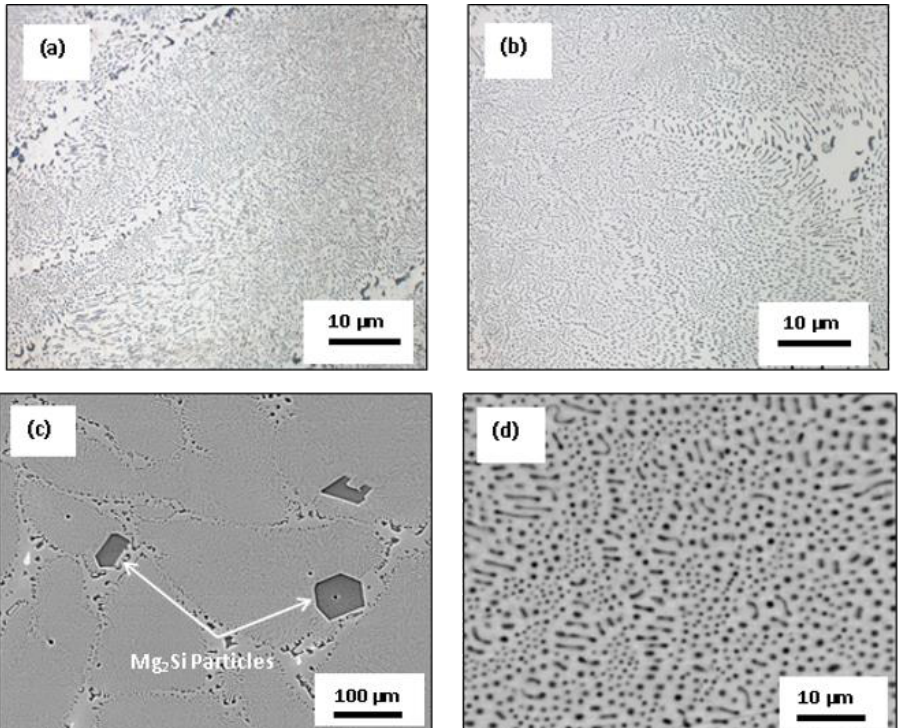
Figure 8. ( a , b ) Optical micrographs and ( c , d ) SEM BS images of the Al-13.1 wt.% Mg 2 Si-300 ppm P alloy with a mold temperature of 350 °C.